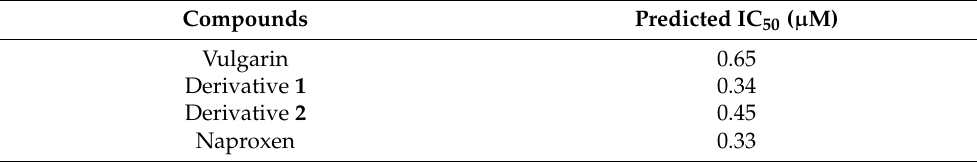
Table 4. InflamNat predicted IC 50 values for the anti-inflammatory activity.